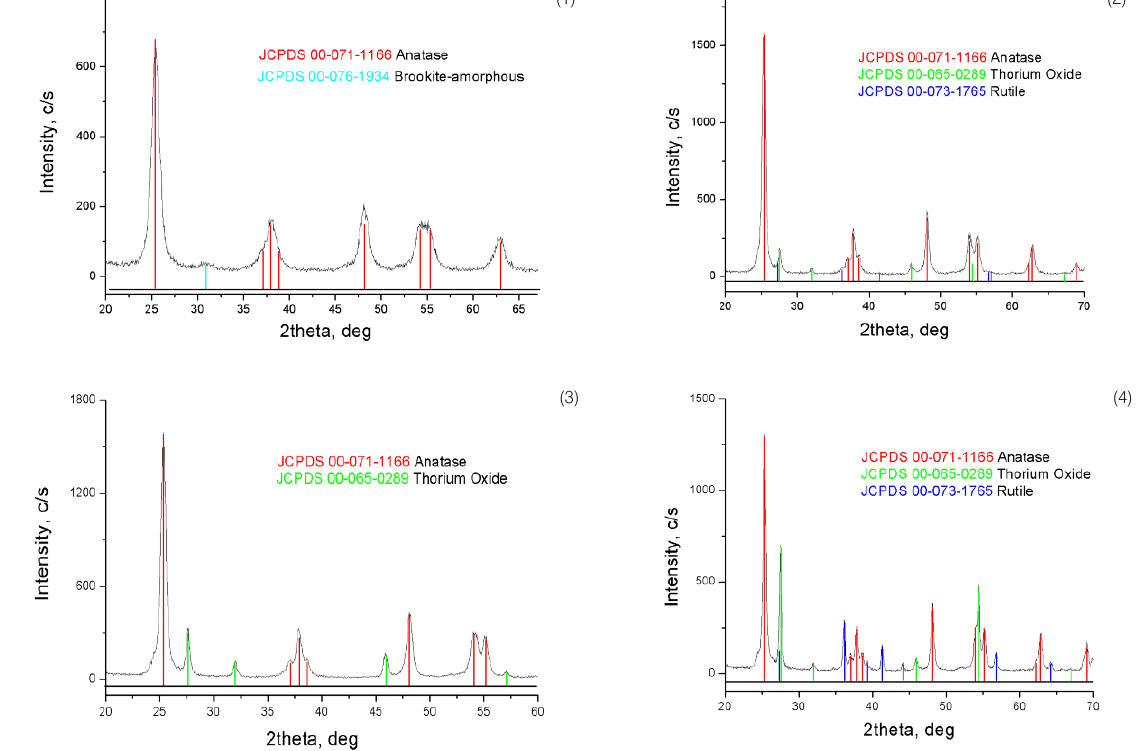
Figure 1. X-ray diffractograms of samples produced at 550 о C: TiO 1%